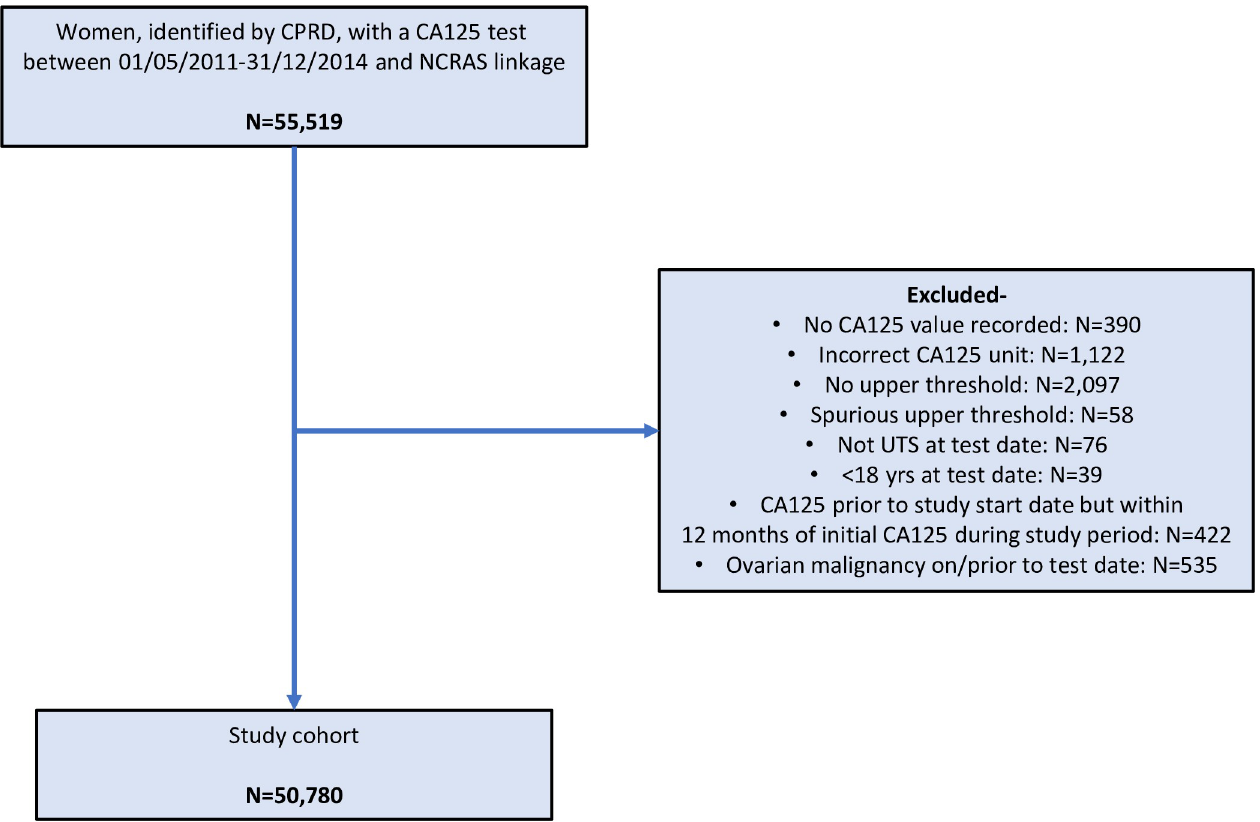
Fig 1. Flow diagram illustrating the identification of the study cohort and application of exclusion criteria. UTS is a quality metric, provided by CPRD, which indicates if the data from a GP practice are of sufficient quality to be used in research [14]. CA125, cancer antigen 125; CPRD, Clinical Practice Research Datalink; NCRAS, National Cancer Registration and Analysis Service; UTS, up to standard.